Question: In one sentence, what is this figure communicating?
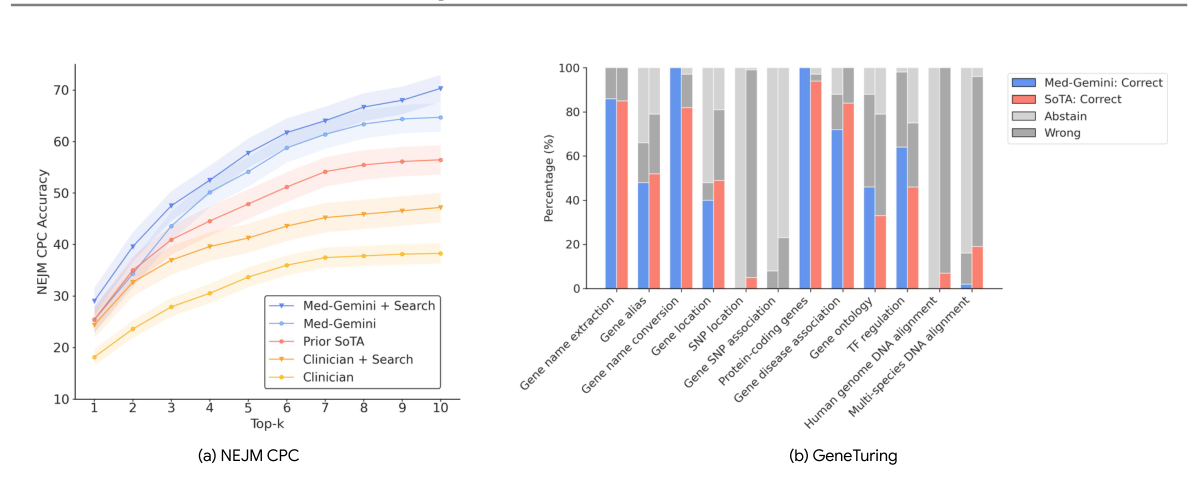
Answer: | Generalization of Med-Gemini-L 1.0 with web search to two additional text-based benchmarks. (a): Comparison of Med-Gemini-L 1.0’s top-k accuracy on the NEJM CPC benchmark with prior SoTA LLMs and clinicians, with and without search. (b): Comparison between Med-Gemini-L 1.0 and SoTA models on the GeneTuring dataset modules. The bars represent the proportion of correct, incorrect, and abstention responses for each model.